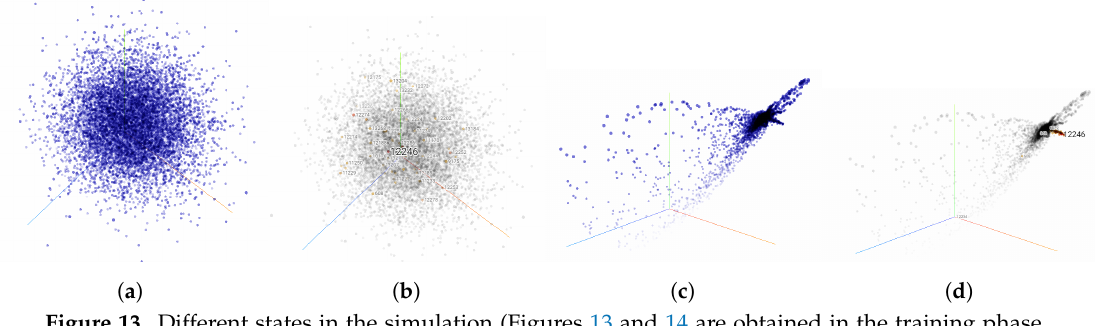
Figure 13. Different states in the simulation (Figures 13 and 14 are obtained in the training phase, and Figure 13b,d are obtained in testing phase) using a T-distributed stochastic neighbor embedding (t-SNE) projector. ( a ) Init state. ( b ) Init state. ( c ) First iterations. ( d ) First iterations.